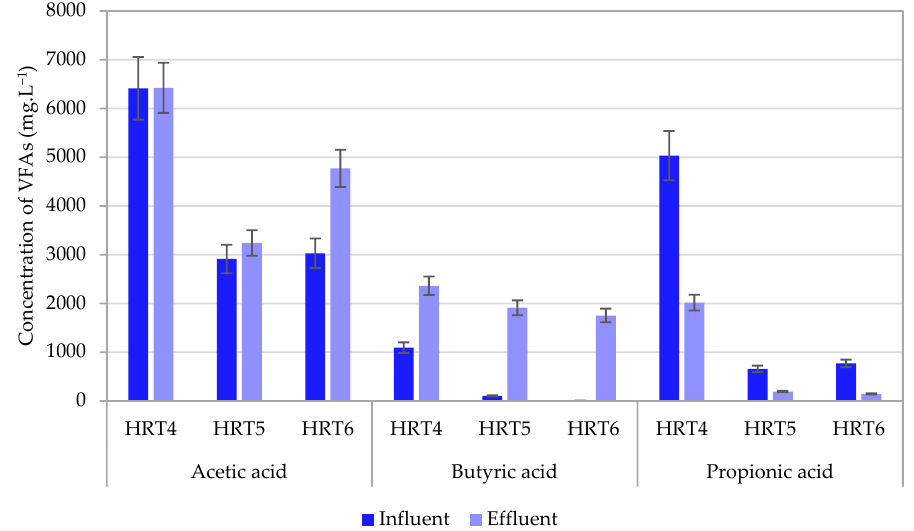
Figure 9. Average concentrations ( n = 3 samples per HRT) of VFAs in the influent and effluent of the DF bioreactor for each of the tested HRTs (error bars: standard deviation).